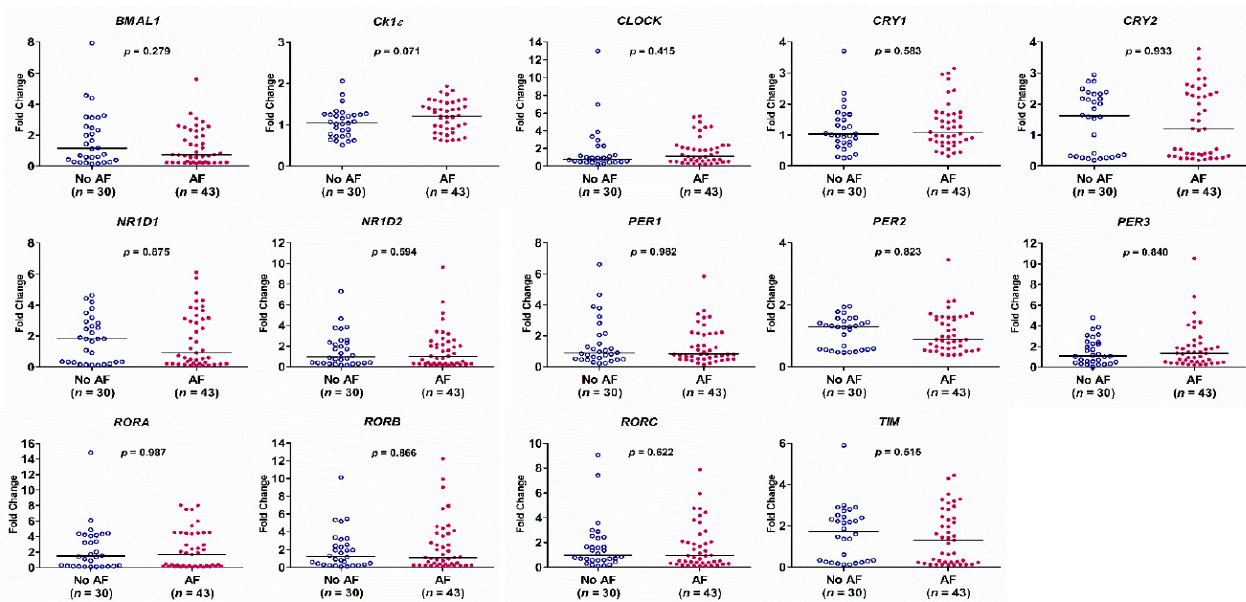
Figure 2. Expression levels of the 14 circadian clock genes in patients with and without atrial fibrillation (AF), as determined by real-time quantitative reverse transcriptase-polymerase chain reaction. The y -axis represents the fold change of the gene expression level in patients with AF compared to patients without AF. The p -value analyzed by Mann–Whitney test indicates statistical significance as evaluated between patients with AF ( n = 43) and without AF ( n = 30) using ∆ Ct values.